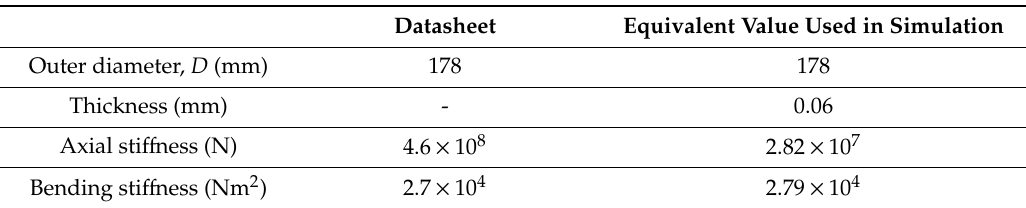
Table 2. Umbilical datasheet and equivalent properties.